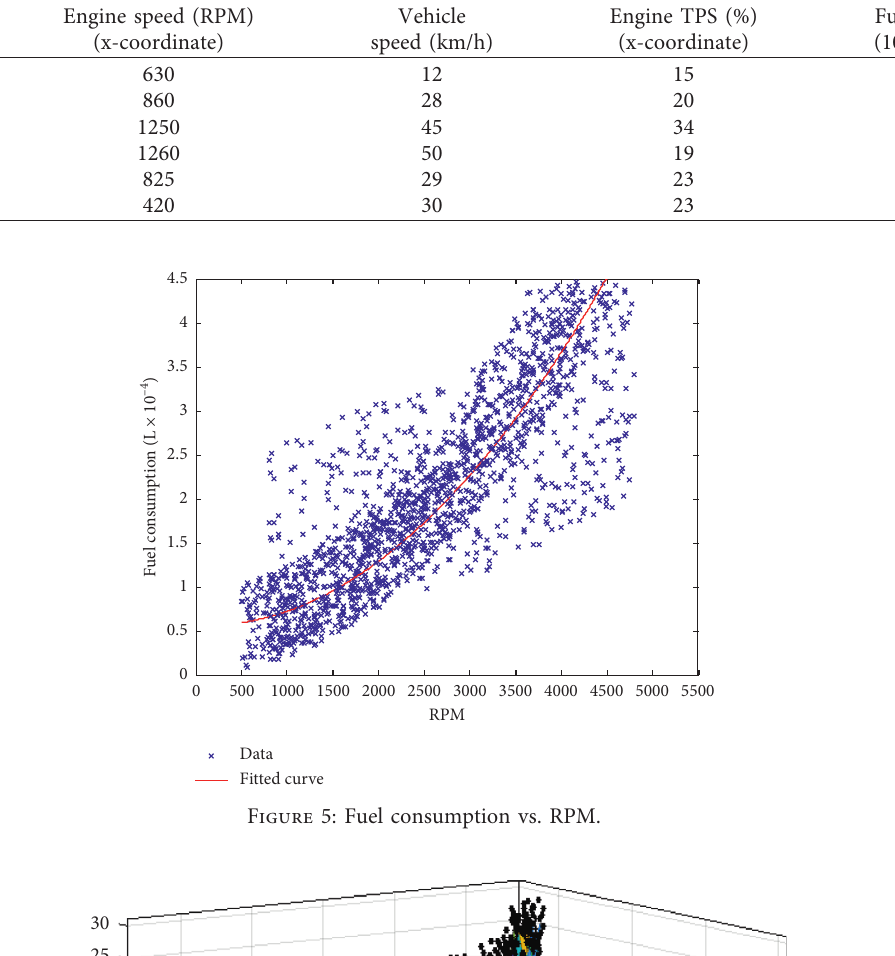
Table 5: Training data: vehicle RPM and TPS.